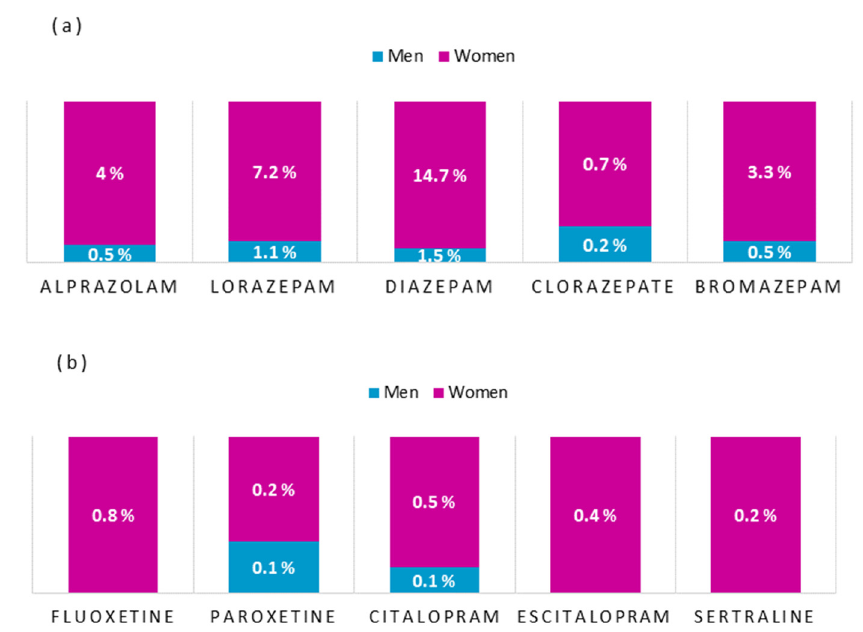
Figure 1. Percentages of ( a ) anxiolytic and ( b ) antidepressant use, by gender.